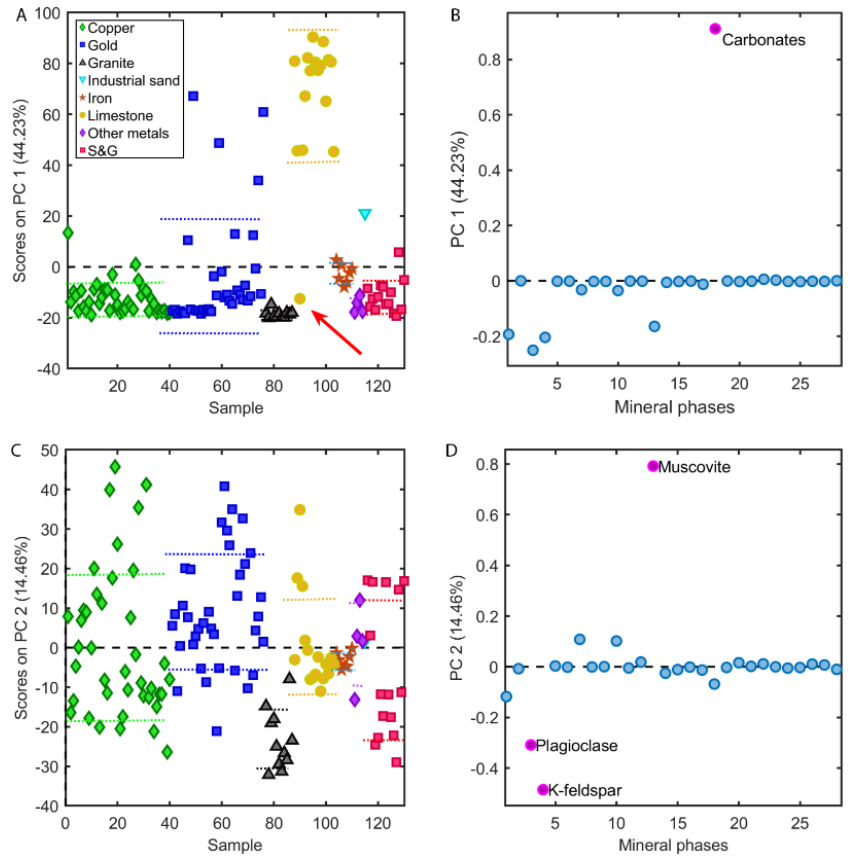
Figure 2. PCA results of XRD mineralogy data ( A ) Sample scores for PC1 v. samples, arrow indicating unique limestone sample; ( B ) Loadings on PC1 v. mineral phases; ( C ) Sample scores for PC2 v. samples; ( D ) Loadings on PC2 v. mineral phases.